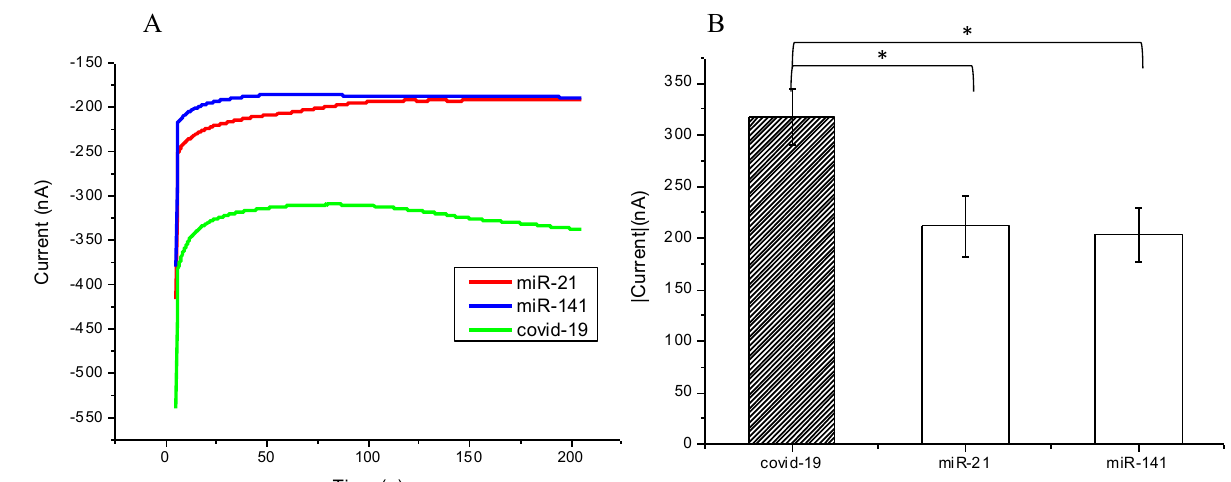
Figure 8. ( A ) Chronoamperometric diagram showing the modified SPCE interaction with different nucleotide sequences, but only binding with the COVID-19 (SARS-CoV-2) target sequence; ( B ) current values also presented significant differences for the COVID-19 sequence and miR-21 or miR-141 ( p -value = 0.0218 and 0.0138, respectively). The bar chart also shows the triple examinations with confidence intervals. * meant p value < 0.005. Table 1. Comparison of our current study results and other similar SARS-CoV-2